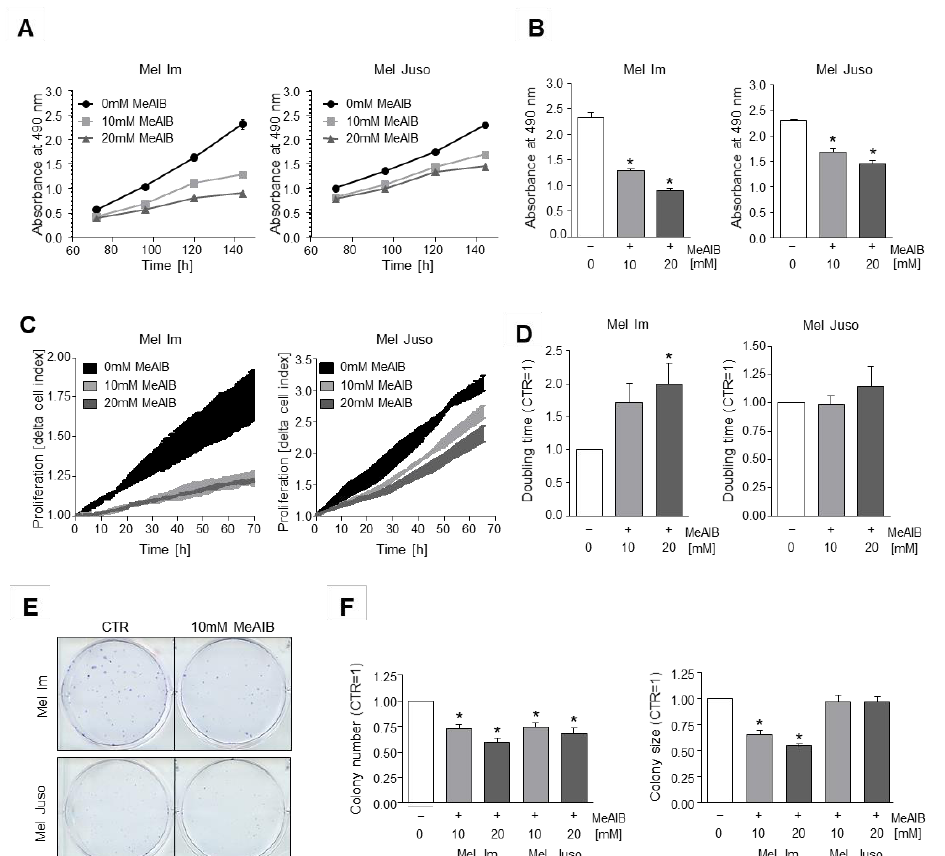
Figure 2. Effects of functional inhibition of SNAT1 on cell proliferation. ( A , B ) Proliferation analysis using XTT-assay of Mel Im (2000 cells) and Mel Juso (4000 cells) cell lines during 10 and 20 mM MeAIB-inhibitor treatment in comparison to control cells (0 mM MeAIB, equal amount of ddH20 was added). ( B ) XTT absorbance after 144 h. Values represent the mean ± SEM of 4 independent experiments. ( C , D ) Quantification of cell proliferation by RTCA of Mel Im and Mel Juso cell lines during 10 and 20 mM MeAIB-inhibitor treatment in comparison to control cells. ( C ) Exemplary image of RTCA curve measuring the delta cell index. ( D ) Quantified doubling time of RTCA–proliferation curve (CTR = 1). p -value for 10 mM MeAIB in Mel Im is 0.0746, p -values for 10 and 20 mM MeAIB in Mel Juso are 0.8855 and 0.4797, respectively. Values represent the mean ± SEM of 3 independent experiments. ( E , F ) Clonogenic assay of melanoma cell lines Mel Im and Mel Juso after 10 and 20 mM MeAIB-inhibitor treatment in comparison to control cells. Exemplary images ( E ) and quantification of colony number ( F left ) and colony size ( F right ). p -values for 10 mM MeAIB and 20 mM MeAIB in Mel Juso are 0.3750 and 0.2297, respectively. Values represent the mean ± SEM of 4 independent experiments. p -value < 0.05 was considered statistically significant